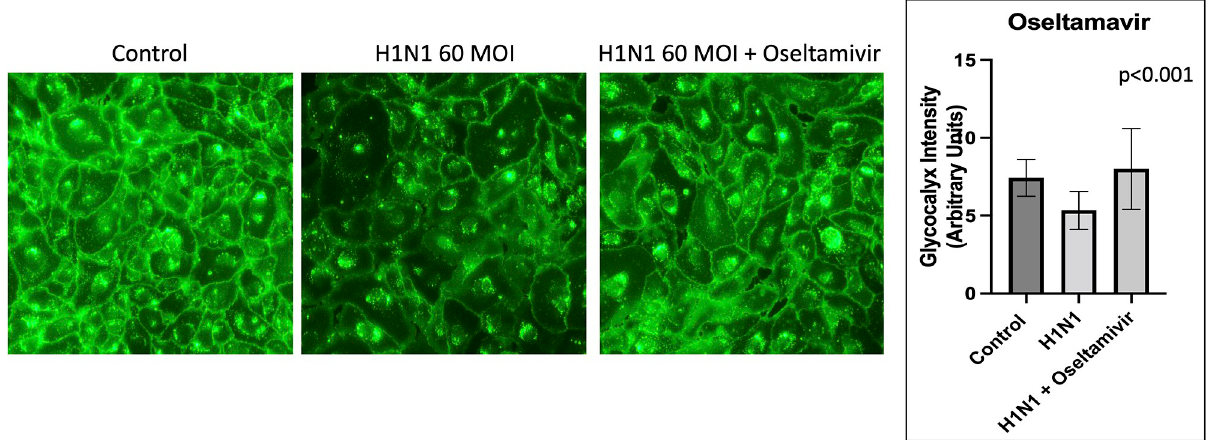
Fig 11. Neuraminidase inhibitors protect the glycocalyx. Representative images and comparison of glycocalyx staining intensity in human umbilical vein endothelial cells shows that glycocalyx staining intensity is preserved when neuraminidase exposure occurs in the presence of the neuraminidase inhibitor Osteltamavir.